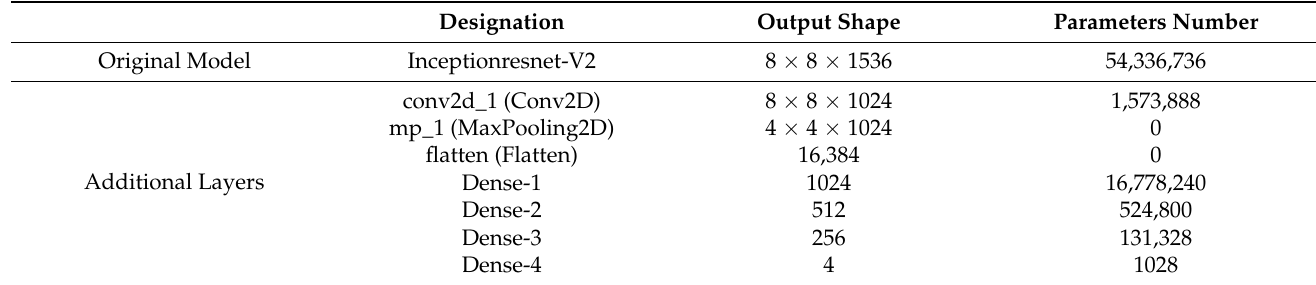
Table 6. The proposed modified-based InceptionResNet V2 model architecture.